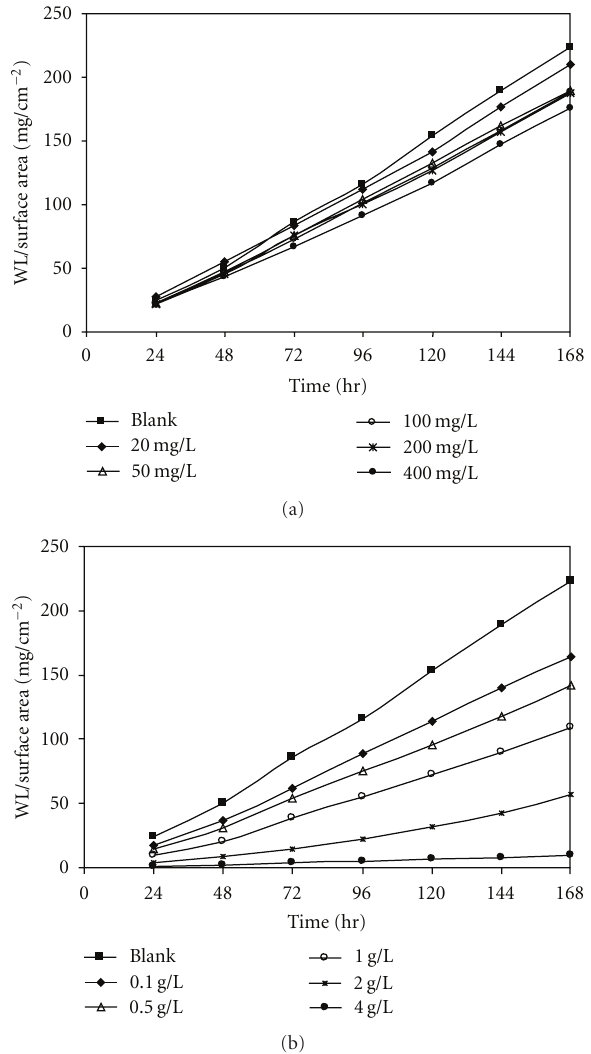
Figure 2: Variation of weight loss per surface area with time for mild steel in 1.0 M H 2 SO 4 containing (a) ATS and (b)